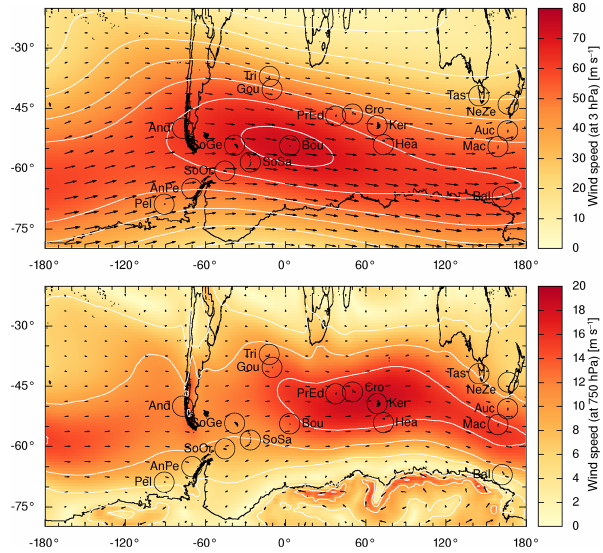
Figure 2. Multi-annual seasonal means (April–October in 2003– 2014) of ERA-Interim horizontal winds at the AIRS observational level (3hPa; top) and at low level (750hPa; bottom). White contour lines appear at levels of 10ms − 1 for the 3hPa layer and 5ms − 1 for the 750hPa layer. Black circles indicate the locations of orographic hotspots that are investigated in this study (see Table 1 for